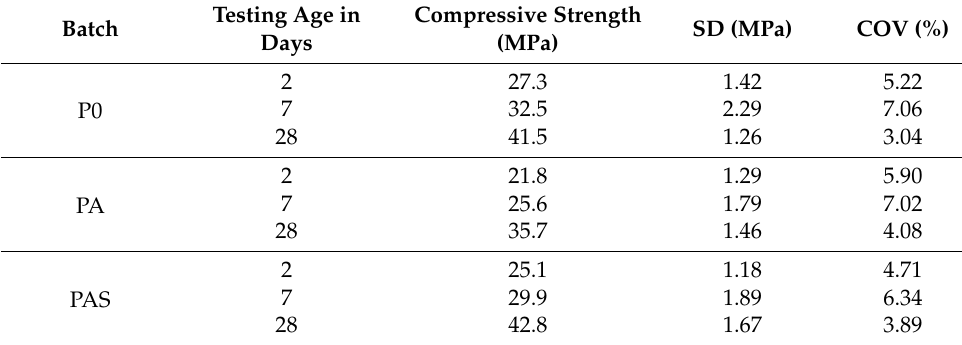
Table 5. Average values of the compressive strength of the studied